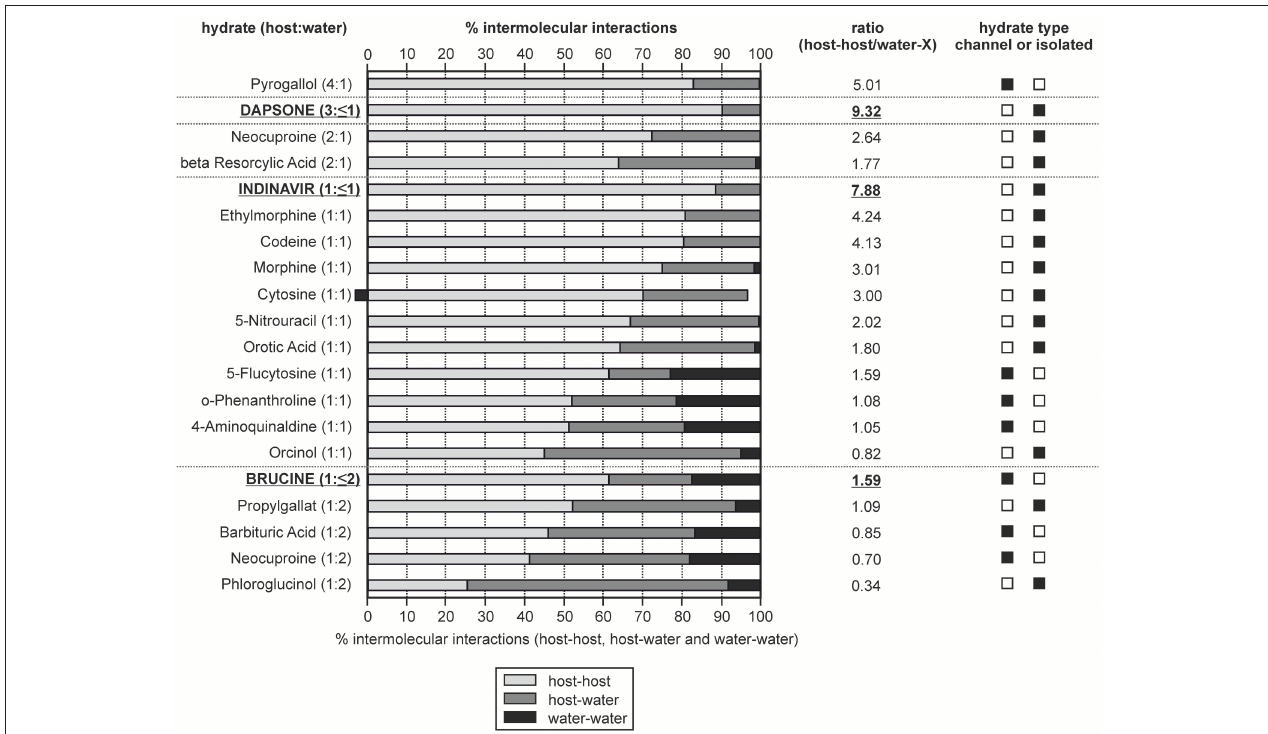
FIGURE 11 | Overall contribution of intermolecular interactions in hydrate structures grouped into host-host, host-water and water-water interactions. The hydrates are ranked according to their compound:water ratio and non-stoichiometric hydrates are indicated in bold and are underlined. The ratio given was calculated as: [(host-host interactions)/(host-water and water-water